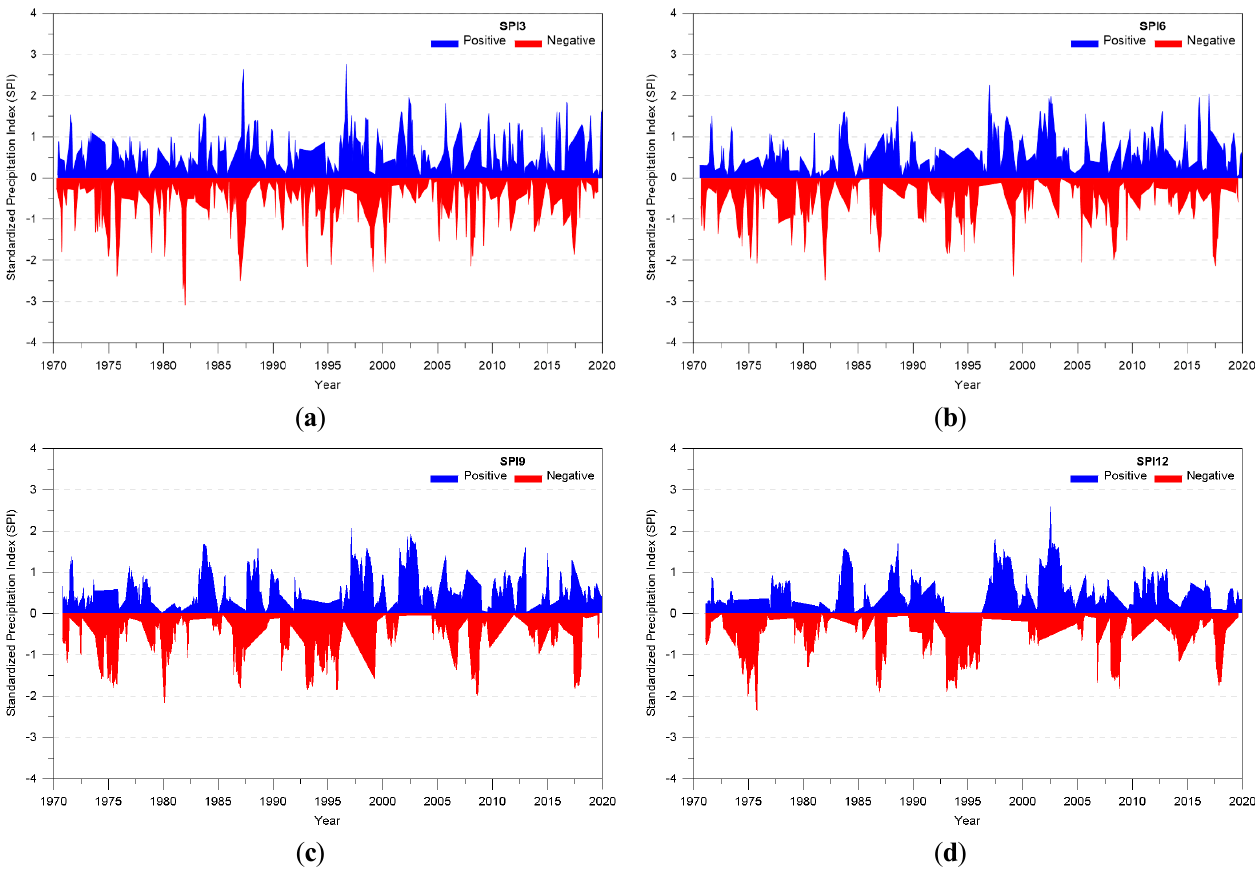
Figure 7. Analysis of the SPI of Gyeongsangnamdo by duration through the application of Thiessen polygons: ( a ) SPI3; ( b) SPI6; ( c ) SPI9; ( d ) SPI12.